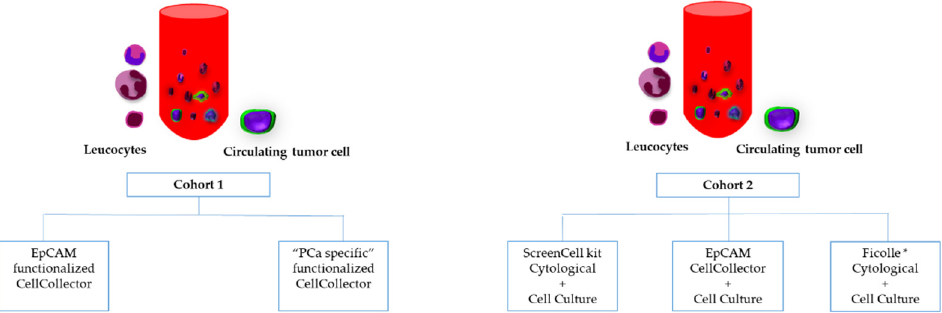
Figure 1. Overview of CTC isolation approaches in the two independent patient cohorts. Abbreviations: Ficoll *: Ficoll + CD45 depletion.